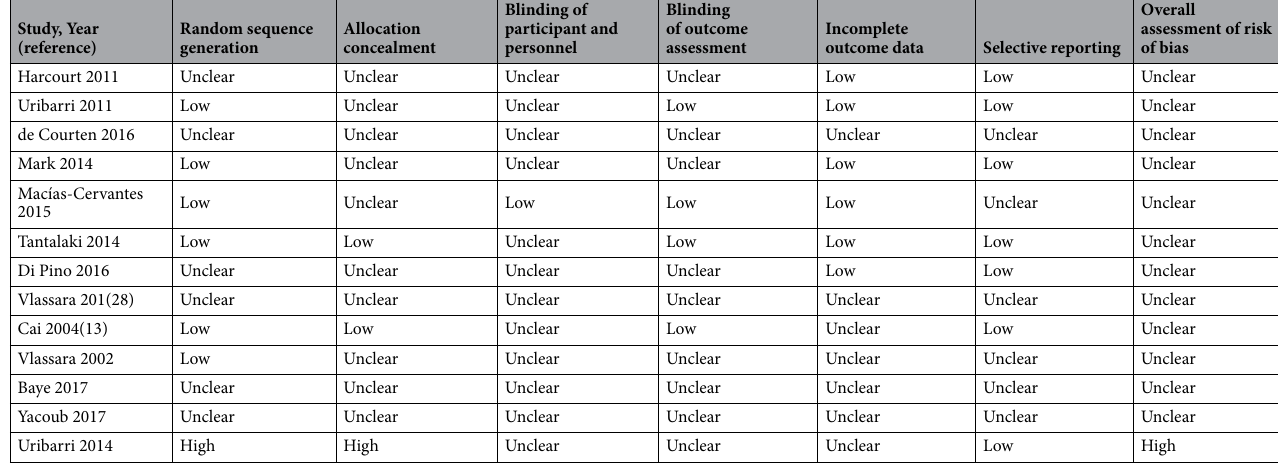
Table 2. Risk of bias assessment according to the Cochrane collaboration’s risk of bias assessment